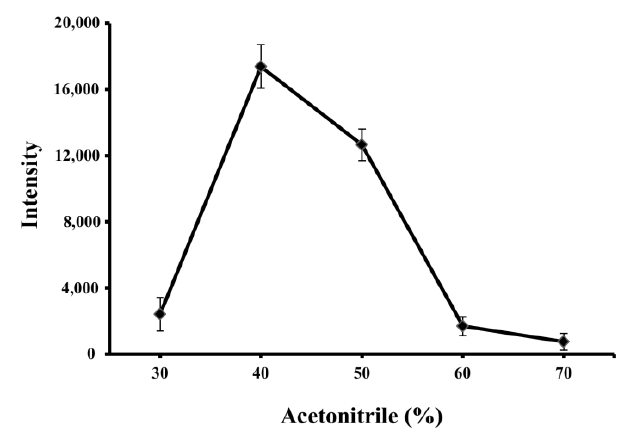
Figure 4. Mass spectra of insulin with an SA solution in 0.1% aqueous TFA containing different amount of acetonitrile. Experimental conditions: sample volume, 3 μL; SA solution volume, 3 μL; and insulin concentration, 5.0 μM. The signal intensities of insulin were evaluated by the peak height of [insulin+H] + ions at m/z = 5778 for 21 sample spots of 3 samples.